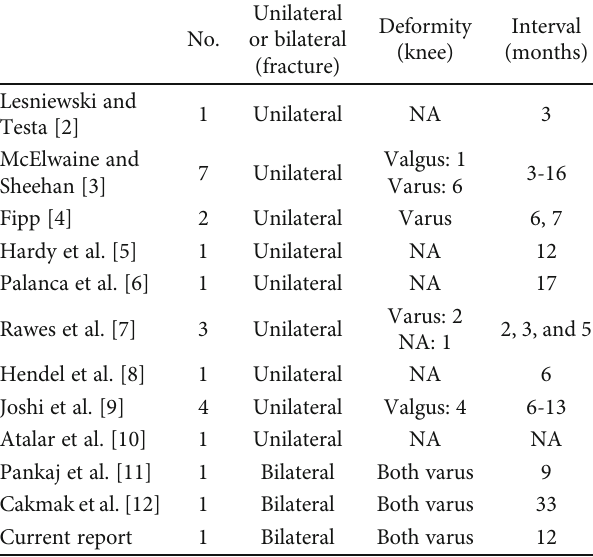
Table 1: Comprehensive data of published literature.